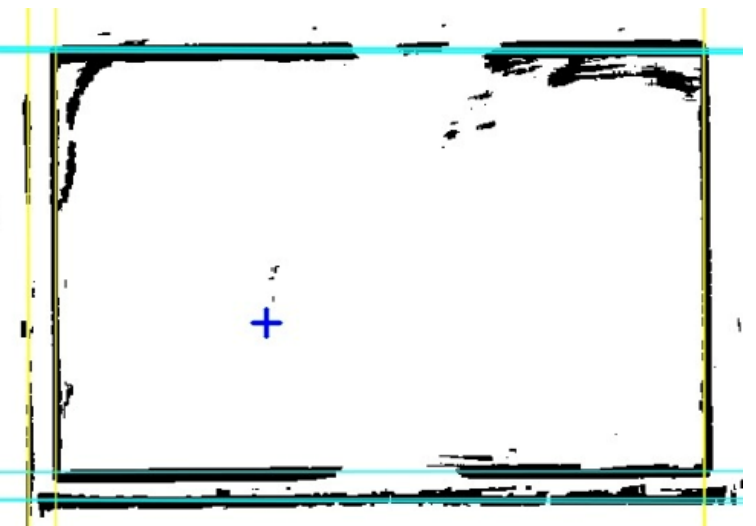
Figure 10. HT line extraction results. Vertical lines extracted from P M x are shown in yellow. Hori- zontal lines extracted from P M y are shown in cyan. The blue + symbol marks the LiDAR position.